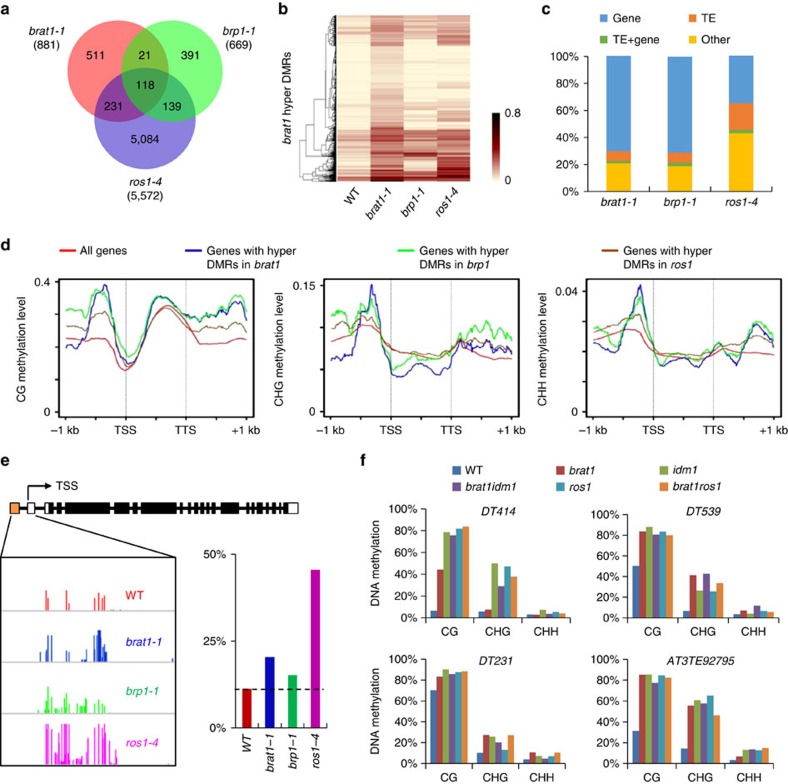
DNA demethylation loci targeted by BRAT1 and BRP1.(a) Numbers of overlapping hyper-DMRs among brat1-1, brp1-1 and ros1-4 mutants. (b) Heat maps of DNA methylation levels within brat1-1 hyper-DMRs. The columns represent the indicated genotypes, and the rows represent the differentially methylated loci. Light yellow indicates low methylation, and black indicates high methylation. (c) Composition of the genomic location of the hyper-DMRs in the brat1-1, brp1-1 and ros1-4 mutants. TE, transposable element. (d) Plots indicate CG, CHG and CHH methylation at genes and their 1-kb upstream and downstream regions in the wild type (WT). Red lines indicate DNA methylation of all genes in Arabidopsis, and blue, green and brown lines indicate DNA methylation of genes with hyper-DMRs in brat1, brp1 and ros1, respectively. TSS, transcription start site; TTS, transcription termination site. (e) The DNA methylation level of the ROS1 promoter region was calculated based on the whole-genome bisulfite sequencing data. The methylation levels of the boxed region are shown by the histograms for WT, brat1-1, brp1-1 and ros1-4. The yellow box indicates the TE region in the ROS1 promoter. (f) The DNA methylation levels of DT414, DT231, DT539 and AT3TE92795 as determined by locus-specific bisulfite sequencing analyses.